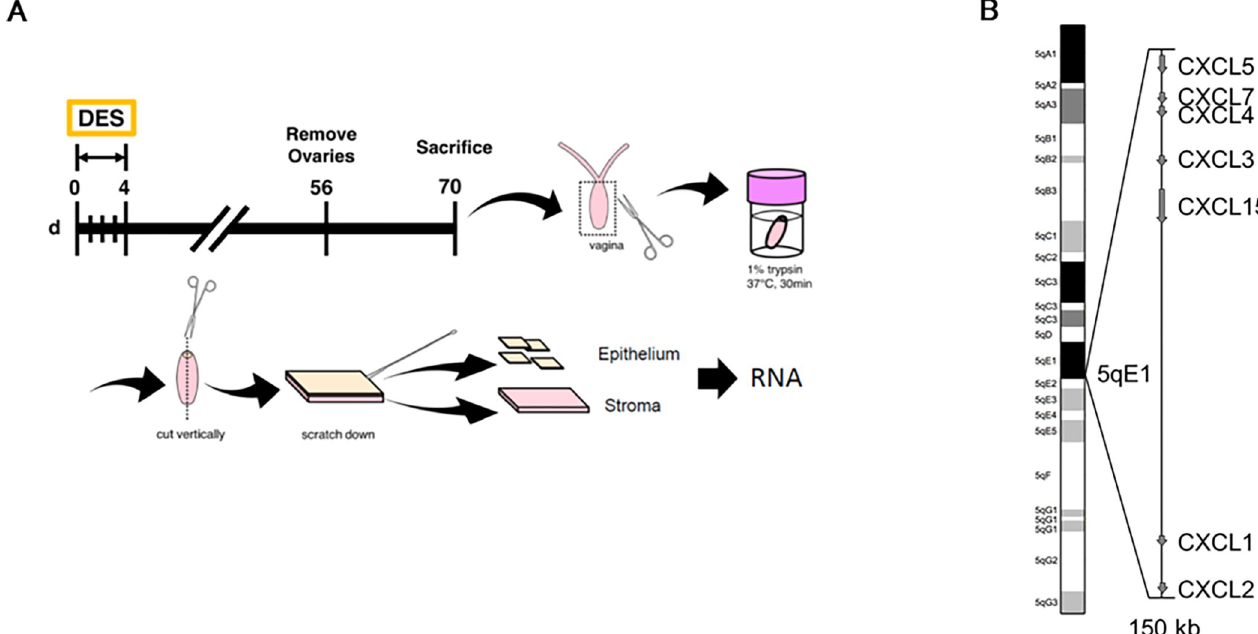
Fig 1. Selection of DES-dependent target genes and Cxcl chemokine gene cluster. (A) Workflow shows the sequential steps and criteria to select DES- dependent target genes using DAVID and qRT-PCR. (B) Schematic representation of mouse chromosome 5 showing that multiple Cxcl chemokine genes are present in the 5qE1 region of chromosome 5. Cxcl 1, Cxcl 2, Cxcl 3, Cxcl 4, Cxcl 5, Cxcl 7, and Cxcl 15 belong to the same cluster (150 kb).